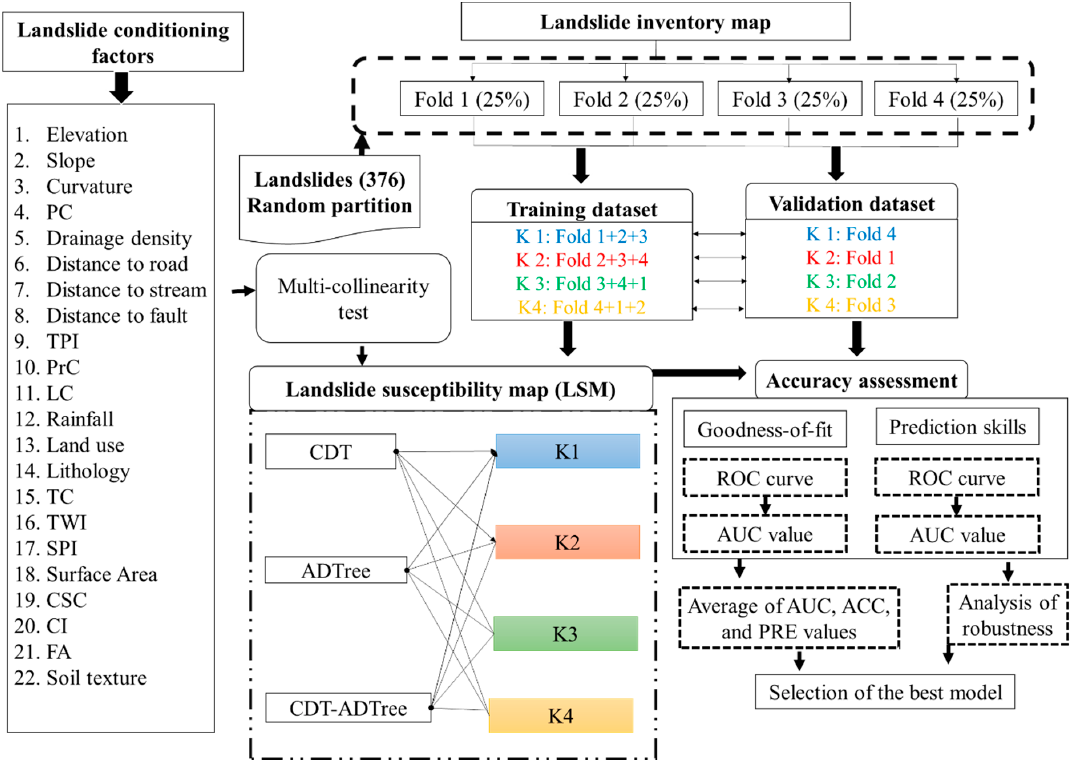
Figure 2. Flowchart of research in the study area.